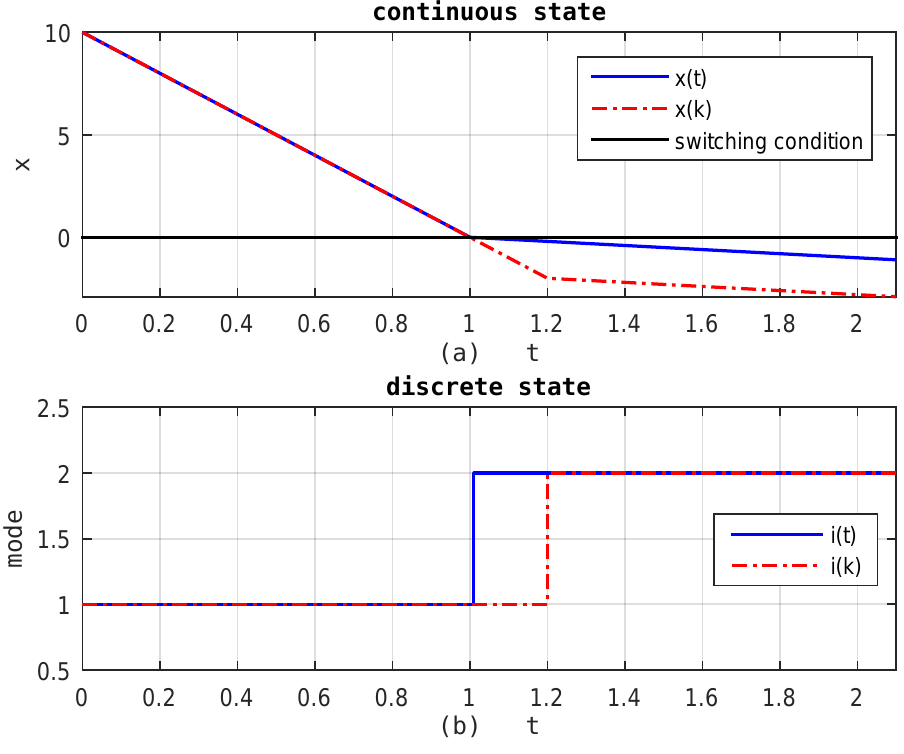
Figure 1. Trajectories of continuous state and